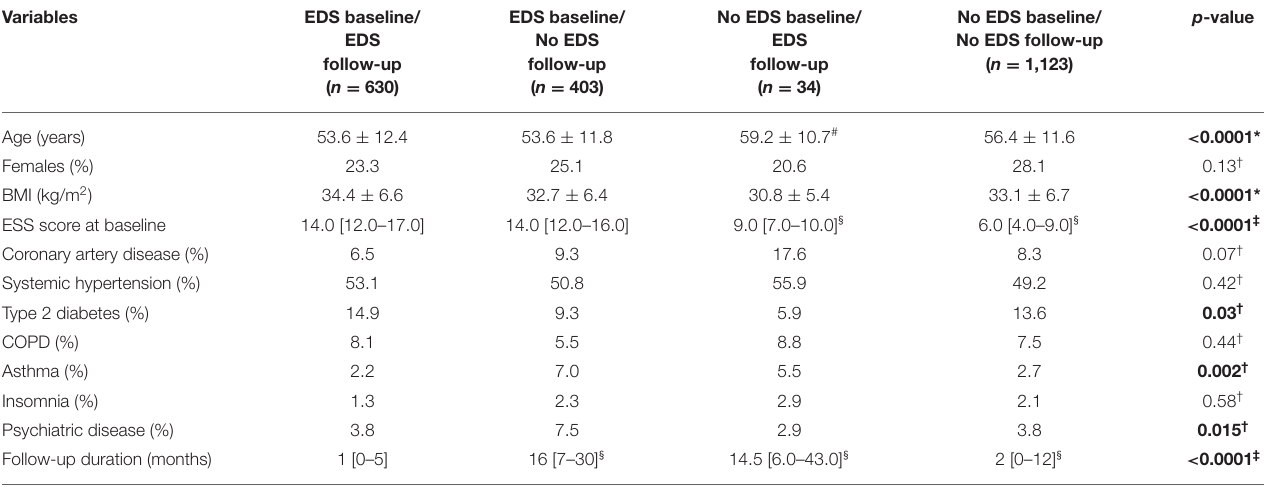
TABLE 3 | Clinical data at baseline according to occurrence of excessive daytime sleepiness at baseline and at the first follow-up visit, n = 2,190.